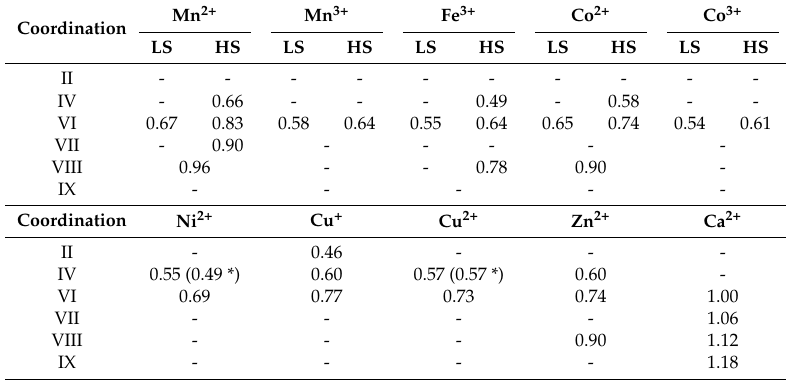
Table 1. Ionic radius (Å) of the different cations involved (LS: low spin, HS: high spin). Bold characters indicate cations and oxidation states incorporated in our